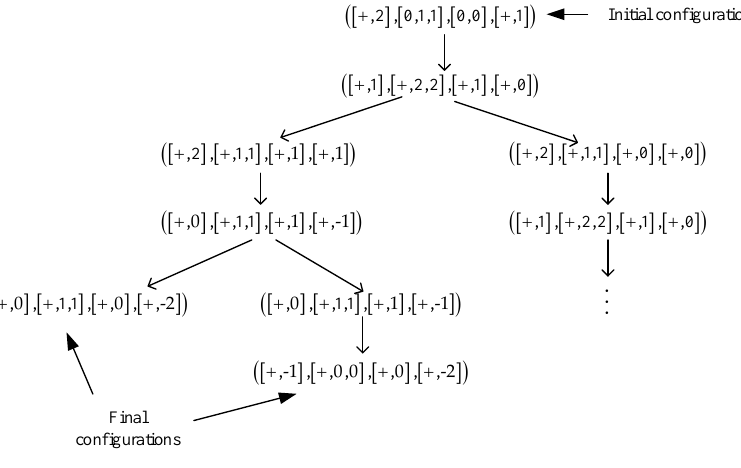
Π . Figure 2. Configuration dynamics of system ex ex